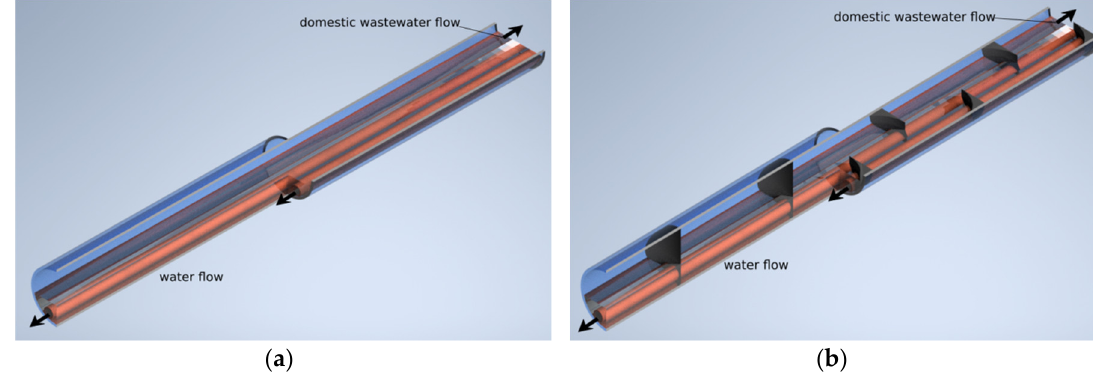
Figure 1. The heat exchangers analyzed: ( a ) HE_0; ( b ) HE_1.